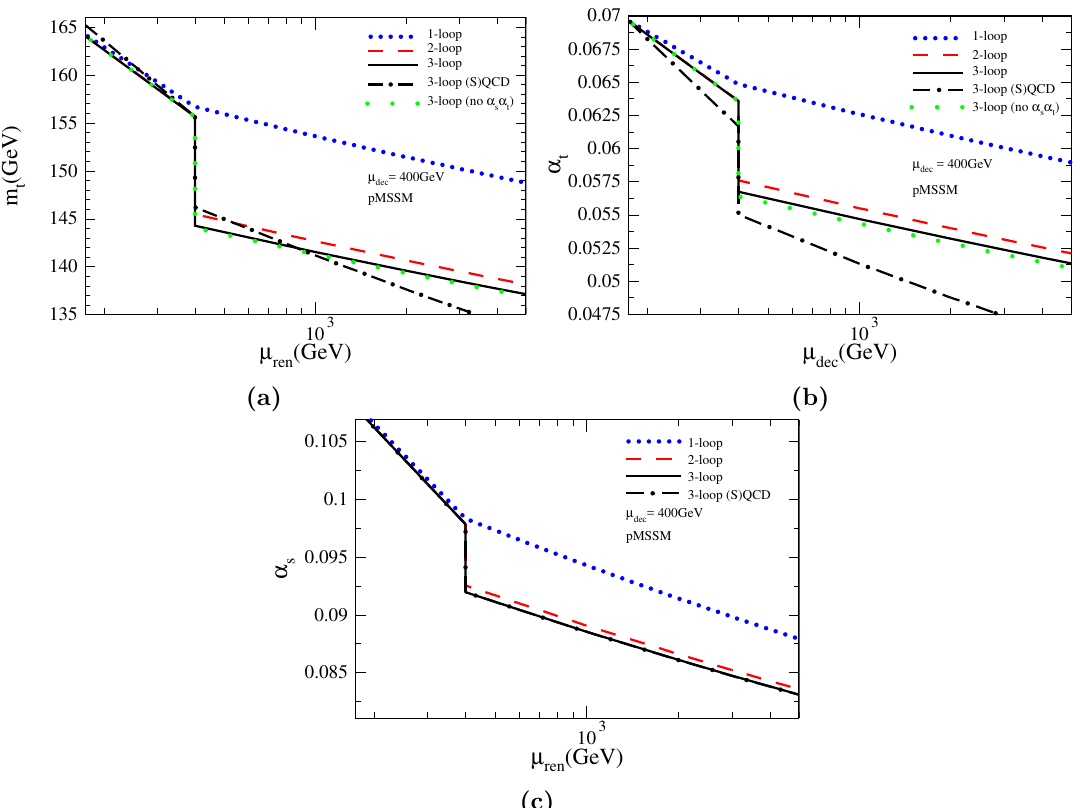
Figure 5. Running of m t , (cid:11) t , and (cid:11) s . The matching scale between the SM and the MSSM is (cid:22) dec = 400 GeV. The convention for the lines is as in the previous plot. The jumps at (cid:22) dec = 400 display the decoupling